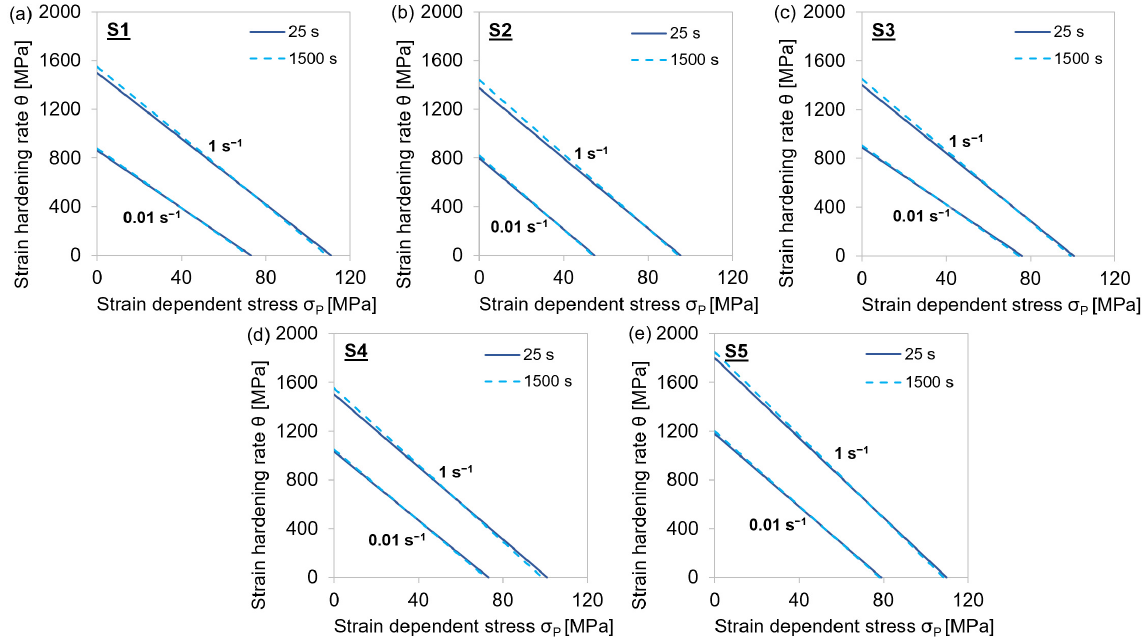
Figure A3. Linear fits of Kocks plots for single-hit compression tests with 25 s holding time before deformation and 0.01 s − 1 strain rate at 913–1473 K. ( a – d ) MA steel grades S1–S4.